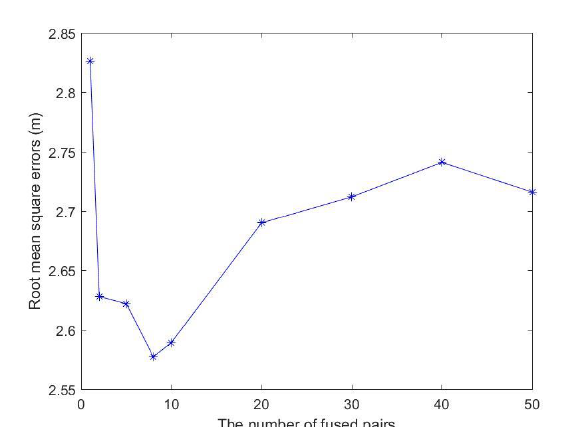
Figure 8. The fused